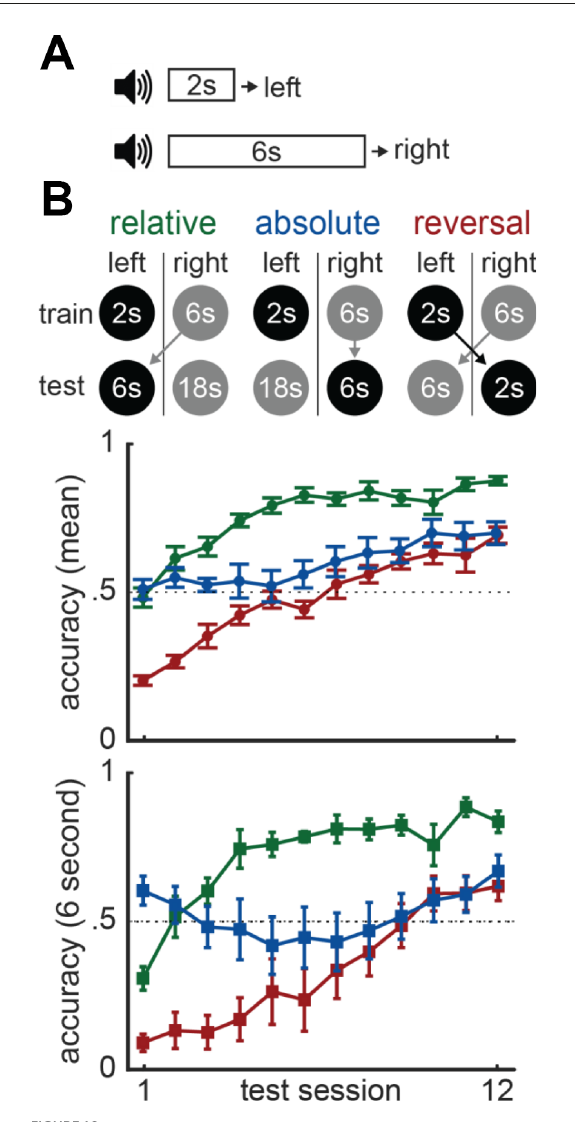
FIGURE10 Absolute vs. relative timing. (A) Temporal discrimination task- design. (B) Task-designs for the three groups included in Akdo˘gan et al. (2020) at the top. Mean accuracy during phase 2 across all trial types are plotted in the middle. Accuracy for 6-s trials alone during phase 2 is plotted at the